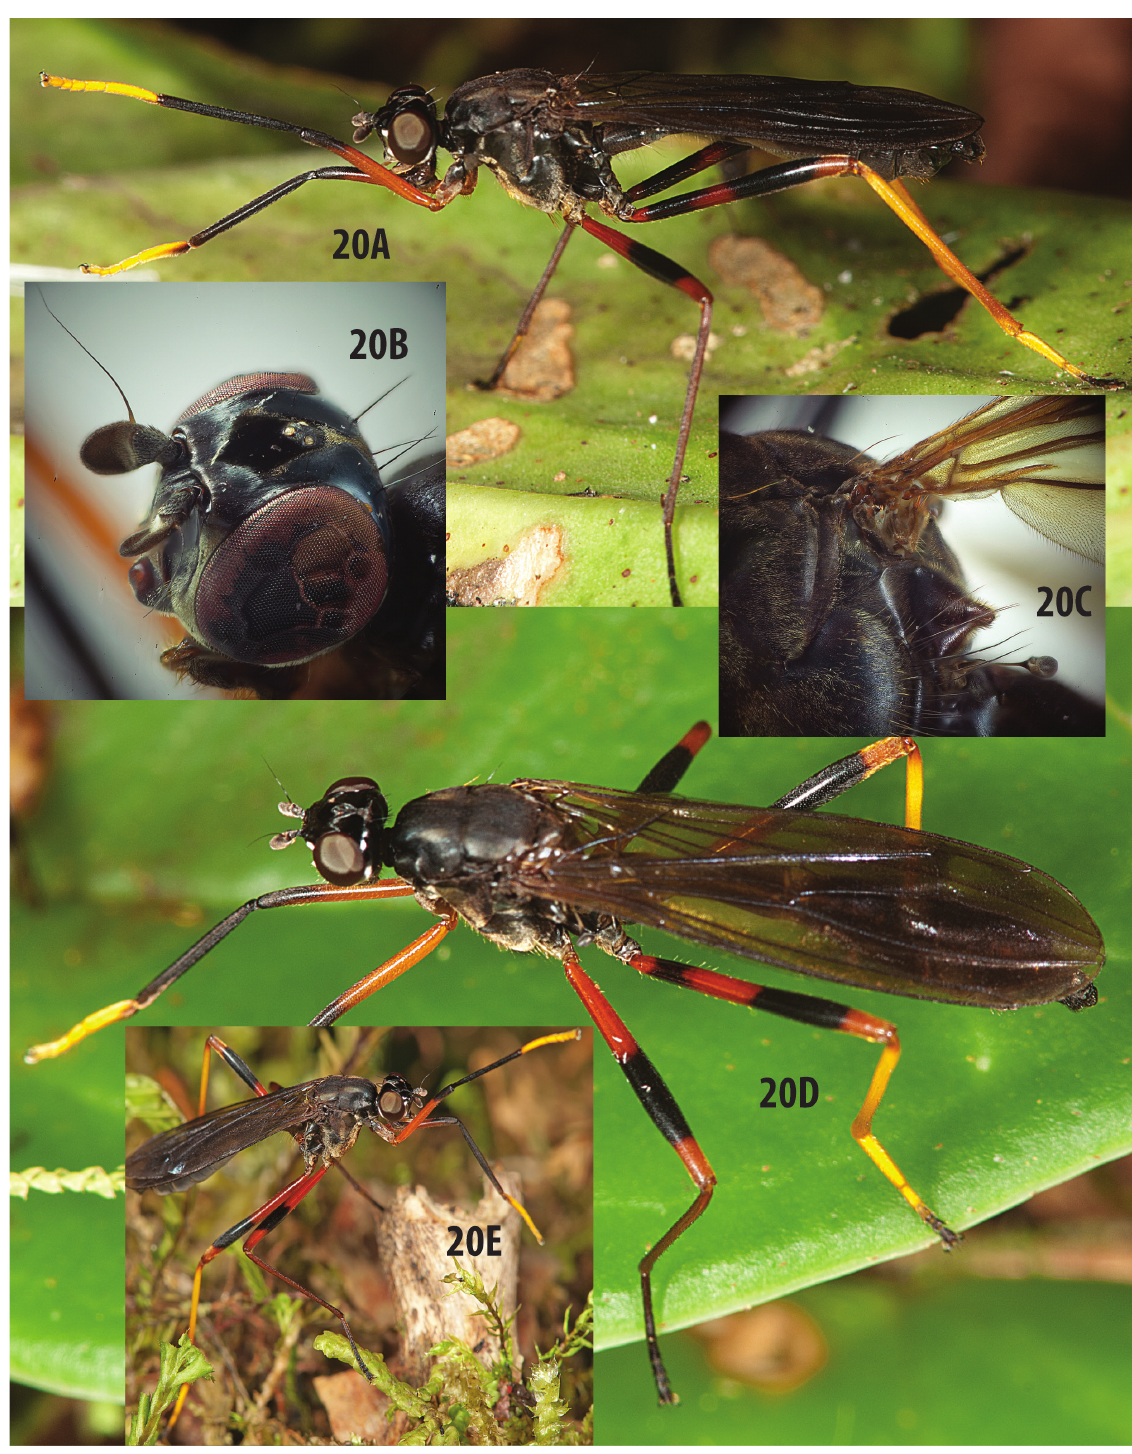
Fig. 20. Mesoconius acca sp. nov., external appearance. A , D–E . Living ♂♂, Wayqecha Biological Station, Peru. B . Head. C . Part of pleuron to show swollen